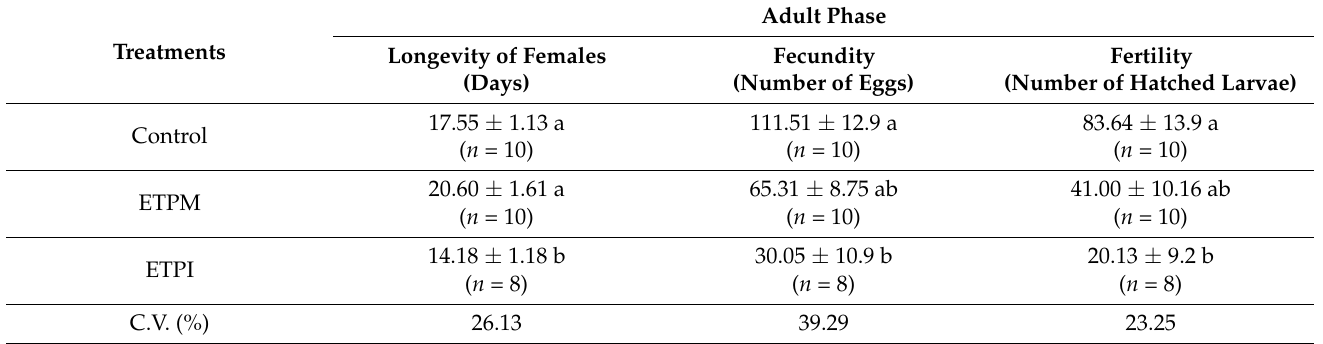
Table 3. Longevity of females, and fecundity and fertility of adult Plutella xylostella in plastic tunnels exposed to different treatments with 10% Tradescantia pallida aqueous extract. (Temp: 23 ± 8 ◦ C, RH: 53 ± 10%, photophase: 13 h ± 36